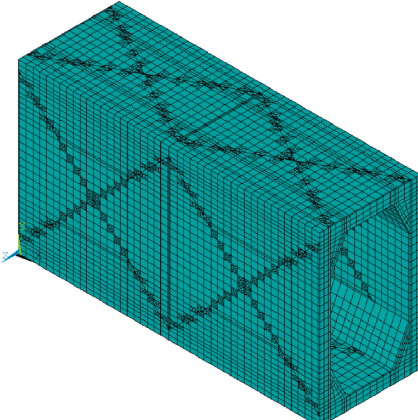
Figure 5: FEM of midspan arch rib concrete element.